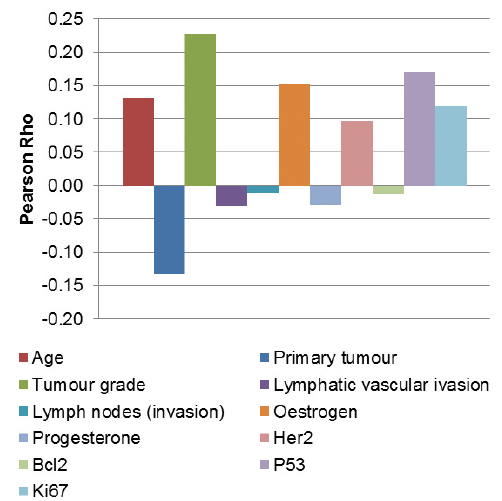
FIGURE 3. LECP show correlation with histological grade of the tumor